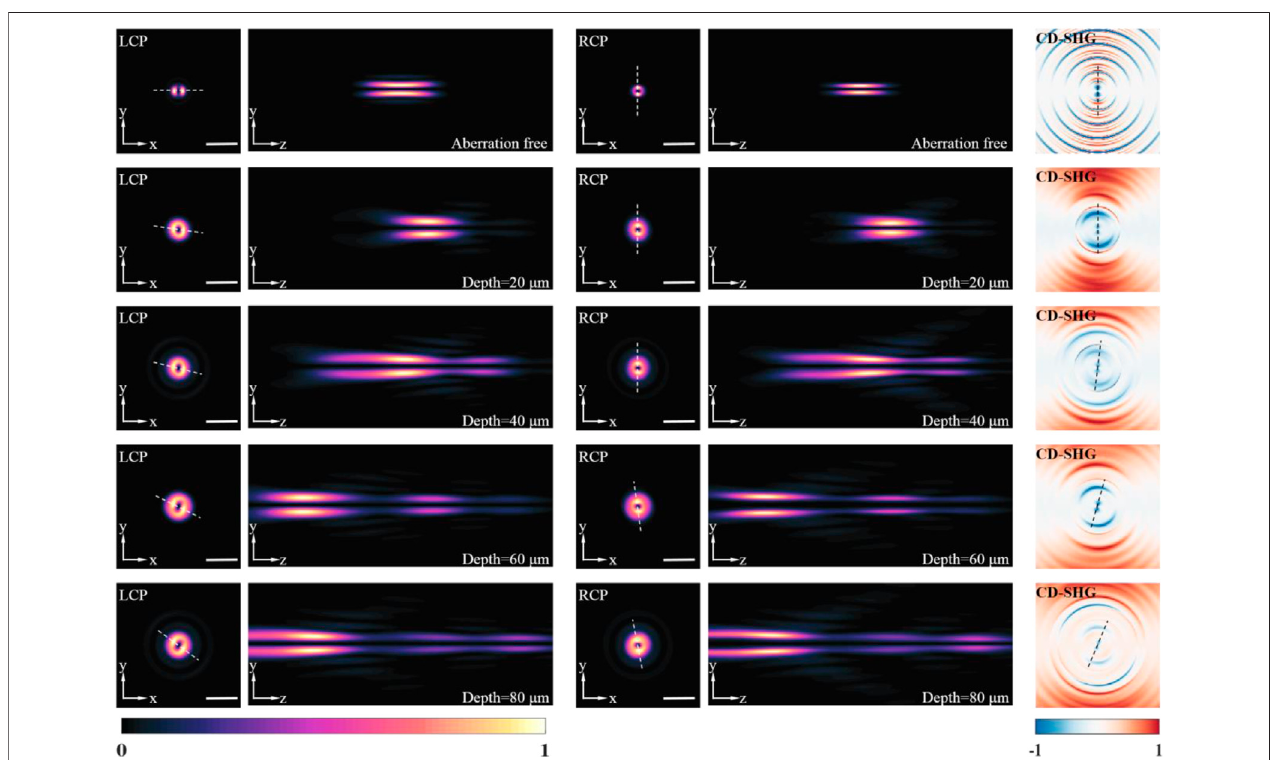
FIGURE2| ThedetectedSHGintensitydistributionsexcitedbyleft-handed,right-handedcircularpolarizedbeamsatdifferentimagingdepths,andcorresponding CD-SHG signal. All the intensity distributions are normalized by the respective maximum value. Scale bar, 1 μ m.